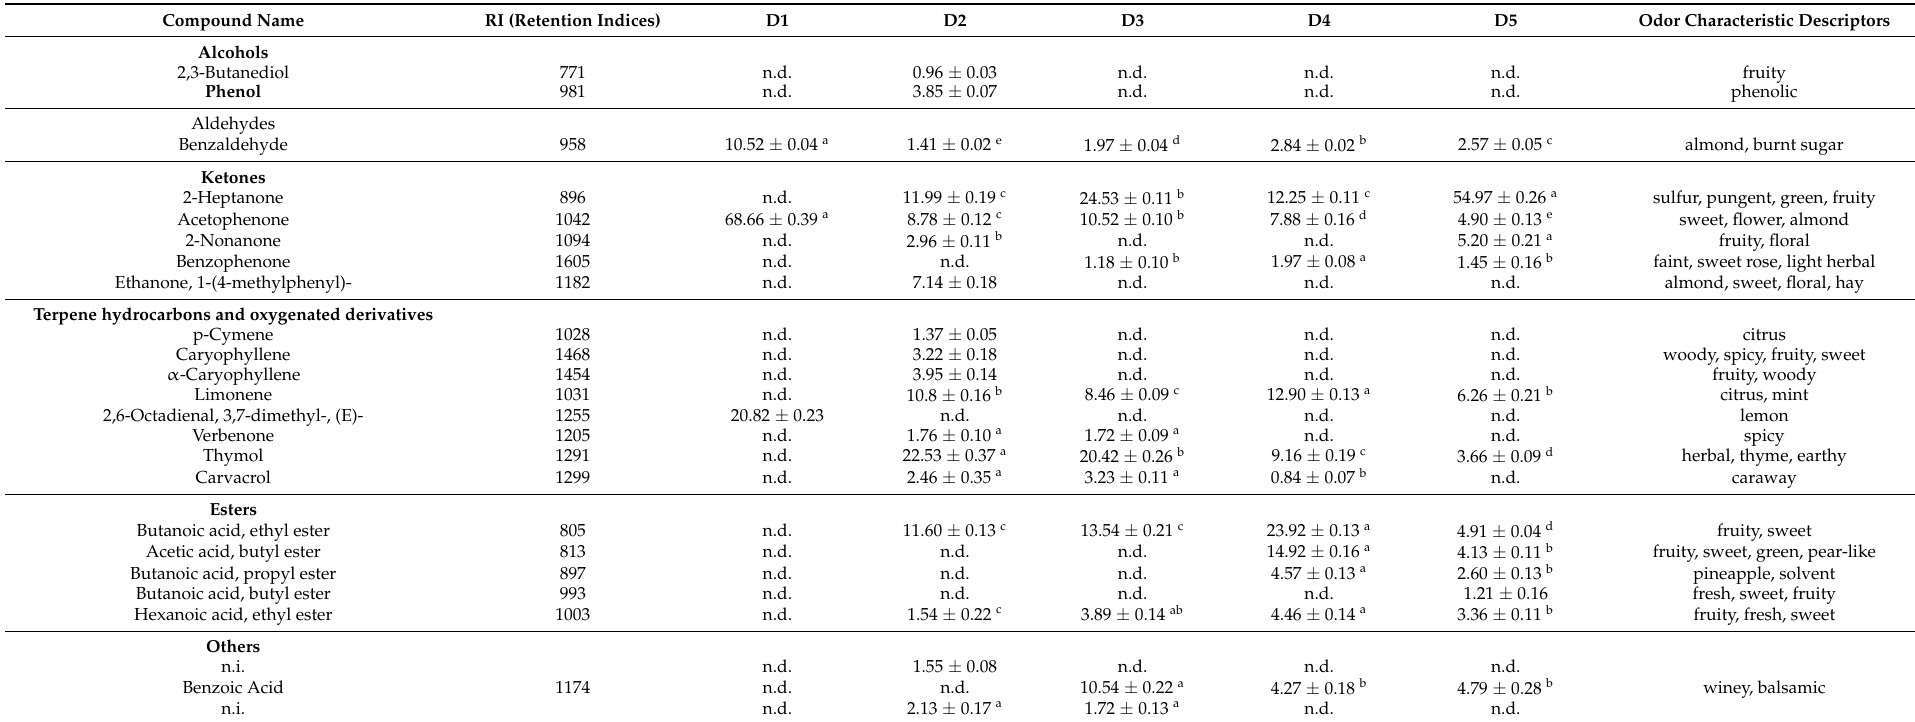
Table 5. Volatile compounds (%) identified in Apuseni cheese samples at five different stages of